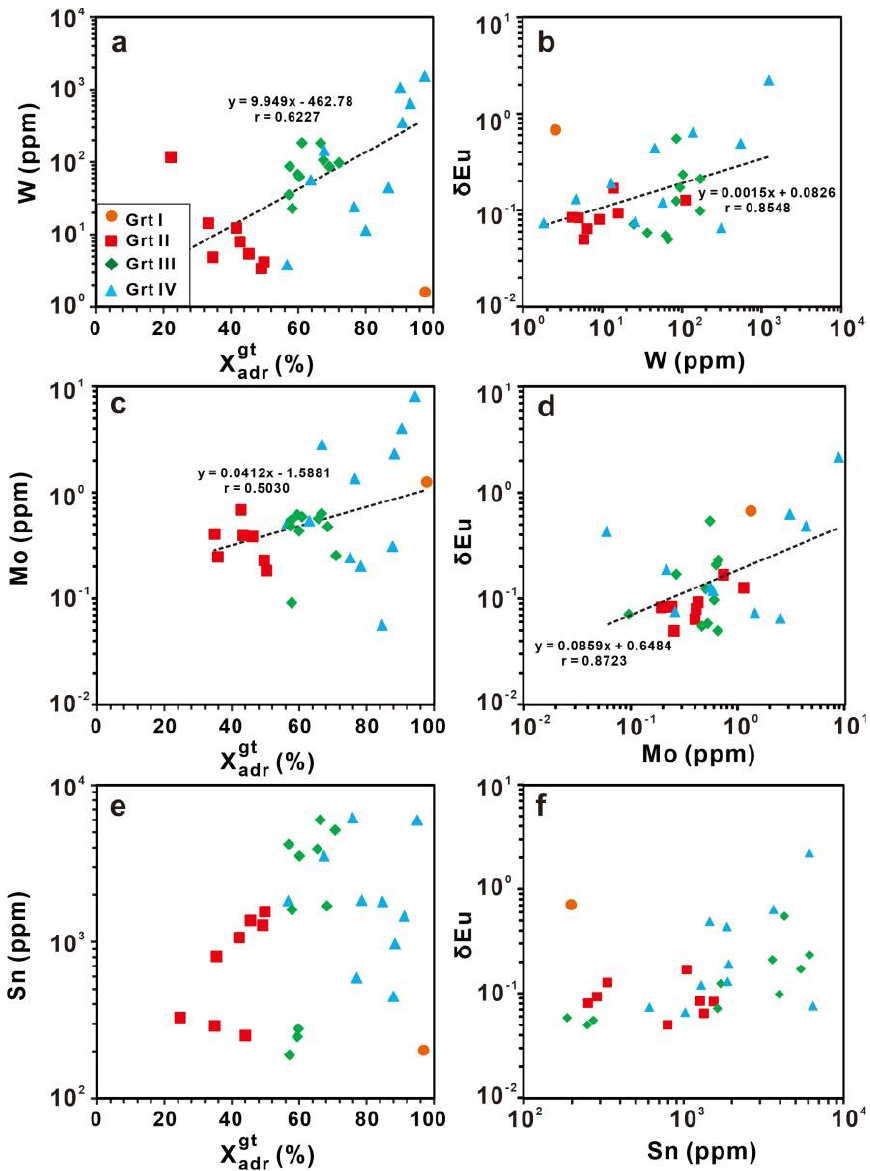
Figure 13. Variations in ∑REE with U ( a ) and Y ( b ) in the garnets of the Huanggang deposit.